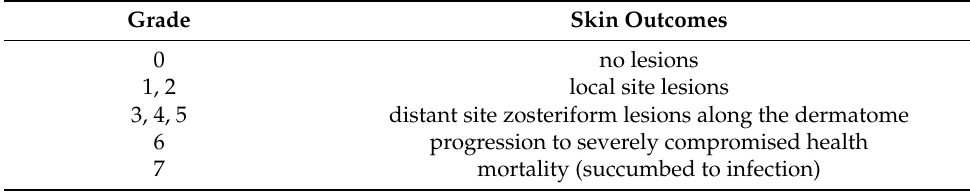
Table 2. Zosteriform infection grading scale.